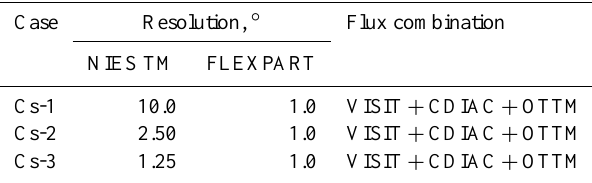
Table 1. The coupled model setups analyzed in this